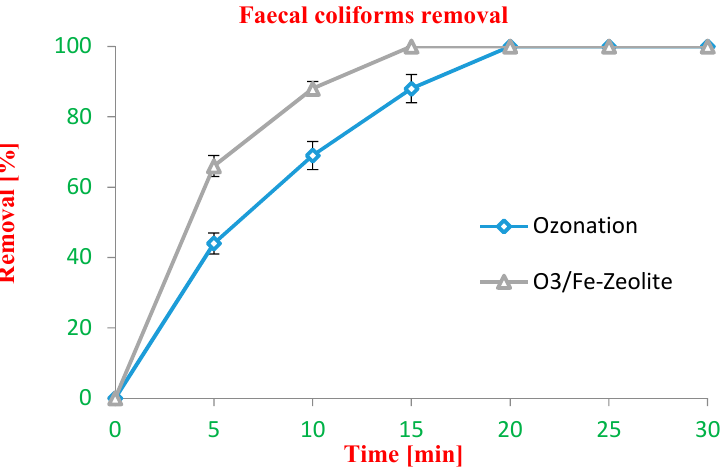
Figure 6. Removal of faecal coliforms in ozonation and catalytic ozonation processes (Initial faecal coliforms = 16 ± 4 MPN/100 mL, ozone dose = 0.2 mg/min, Fe-ZA dose = 10 g/L, pH = 8.2 ± 0.3, volume = 1 L, time = 30 min, T = 33 ± 2 °C).